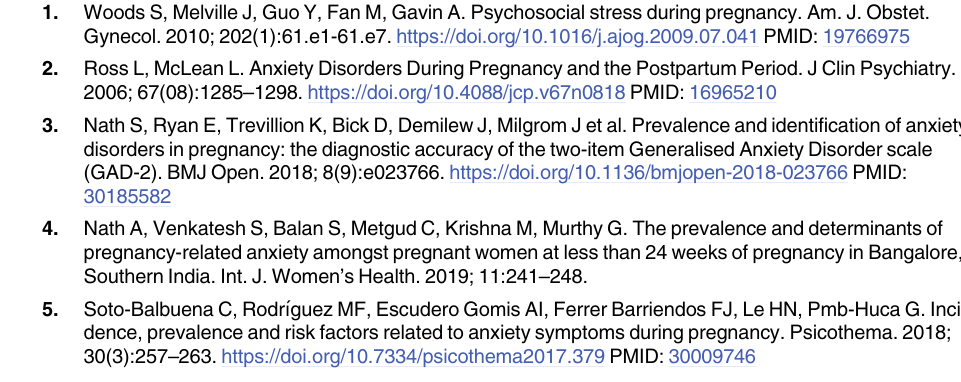
S1 Table. SAIL Databank data sources. S2 Table. Data definitions. S3 Table. Coding framework detailing the themes, subthemes and definitions from the qualitative analysis of women’s experiences of pregnancy during the COVID-19 pandemic. S1 Text. Software used for